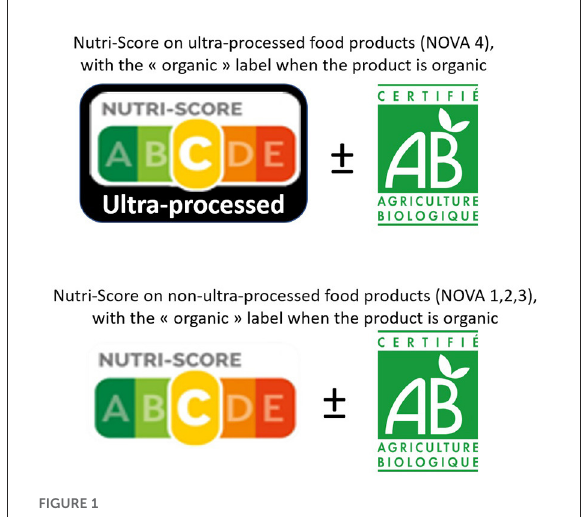
FIGURE1 Proposed front-of-package label, including the 3 health dimensions of